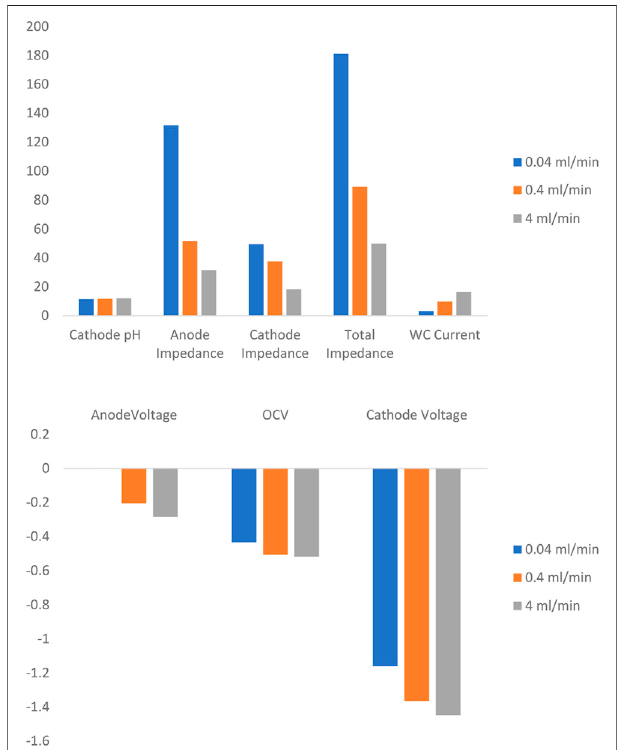
FIGURE 3 | Average response of selected summary statistics to increasing fl ow rates ranging from 0.04 ml/min to 4 ml/min. The voltage measurements are all in Volts, Impedance measurements are in Ohms, and Current measurements are in Milliamperes.